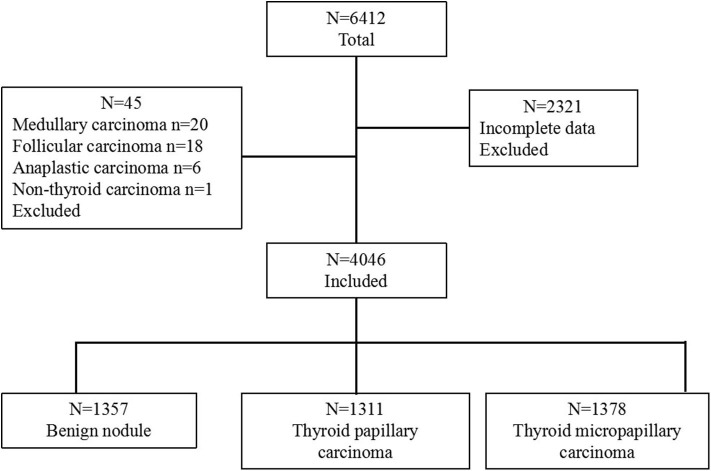
Flow chart showing the categorization of 6,412 patients into 3 groups based on diagnosis. The group with 4,046 patients was further categorized into 3 pathological groups: benign nodule, thyroid papillary carcinoma, and thyroid micropapillary carcinoma.